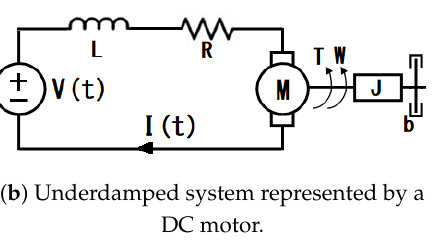
Figure 4. Systems used for the ANNs tests with real